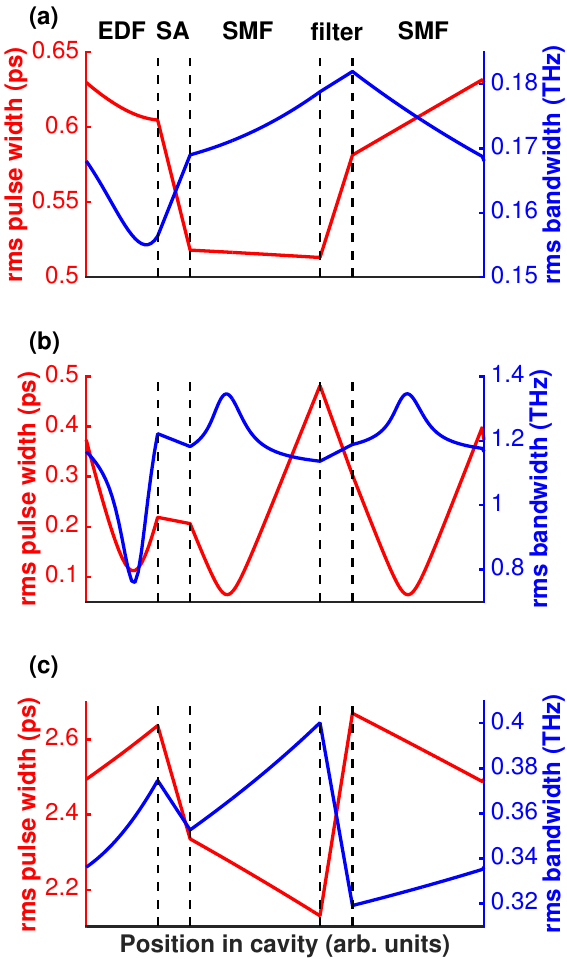
Figure 8. Simulated evolution of the rms temporal (red) and spectral (blue) widths of the pulse along the cavity for the ( a ) soliton, ( b ) DM soliton and ( c ) DS regimes. Adapted from